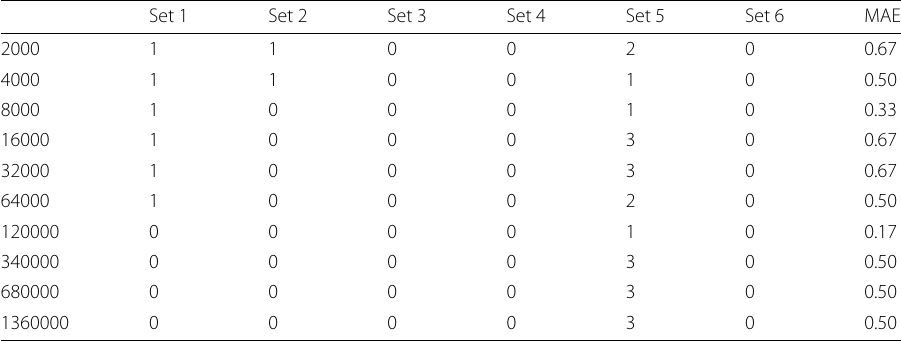
Table 5 Accuracy of the heuristic in relation to the classical algorithm for each set of